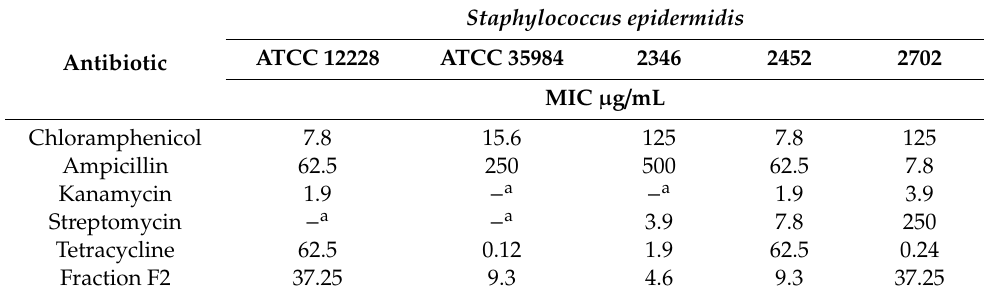
Table 2. MIC of antibiotics and fraction F2 of Naja ashei venom on S. epidermidis certified and clinical strains.